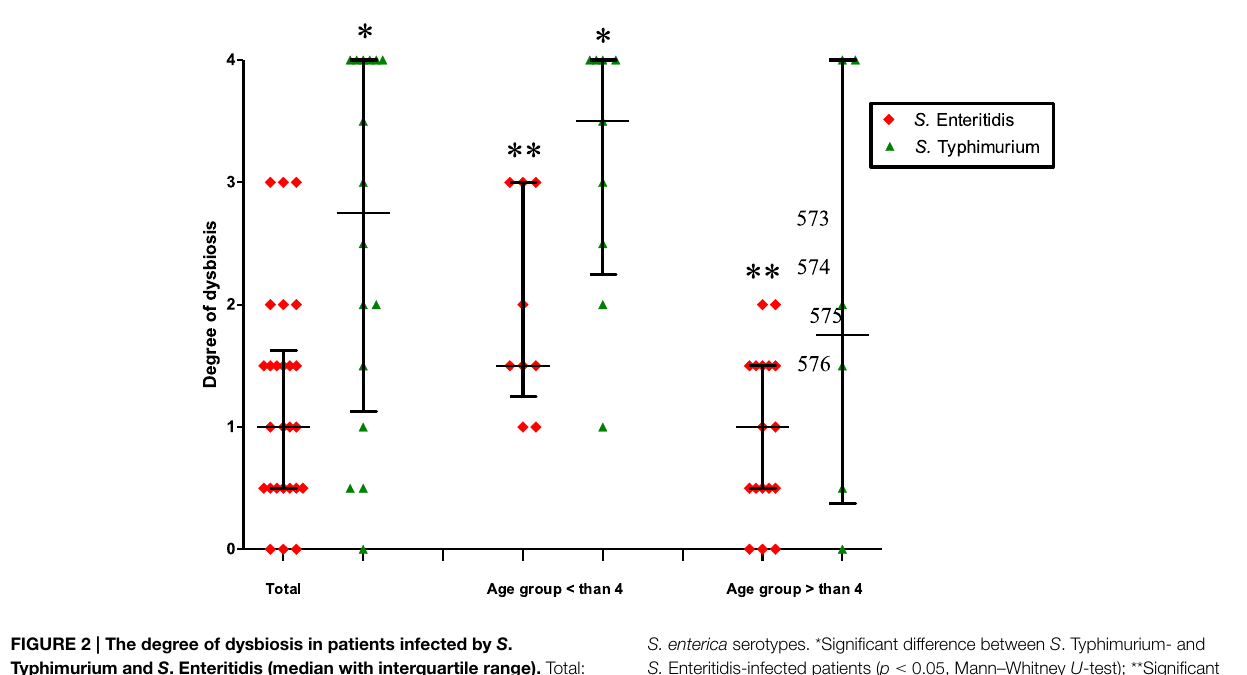
FIGURE 2 | The degree of dysbiosis in patients infected by S . Typhimurium and S . Enteritidis (median with interquartile range). Total: all patients infected by S . Typhimurium or S . Enteritidis, irrespective of age; the second and third columns: patients are separated according to age and